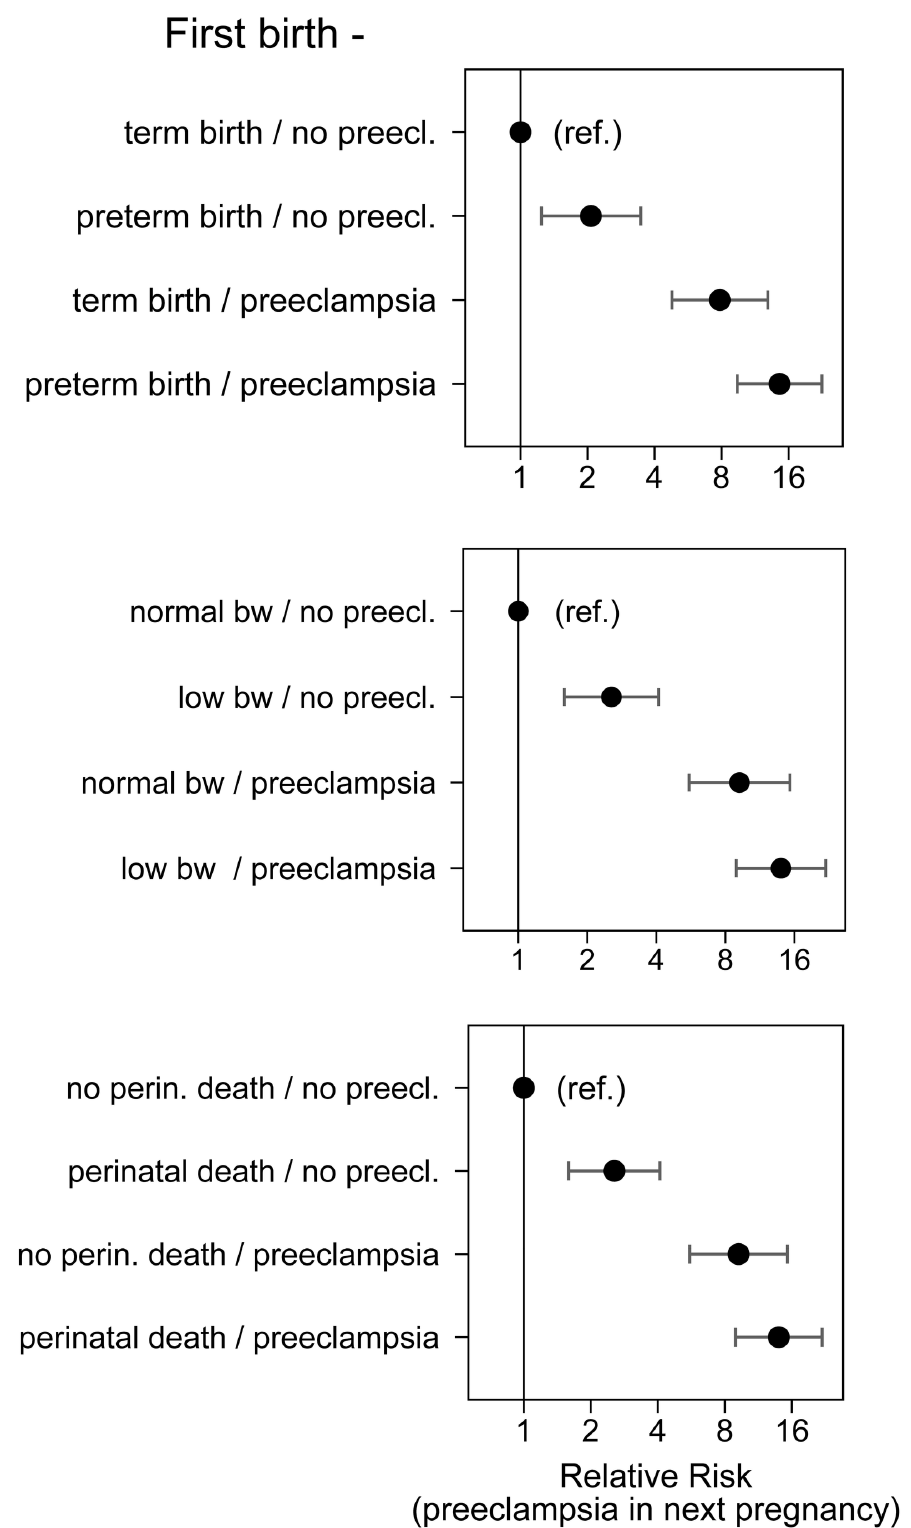
Figure 2. Conditions of the first pregnancy (preeclampsia in combination with preterm birth, low birth weight or perinatal death) and the risk of preeclampsia in the next pregnancy.